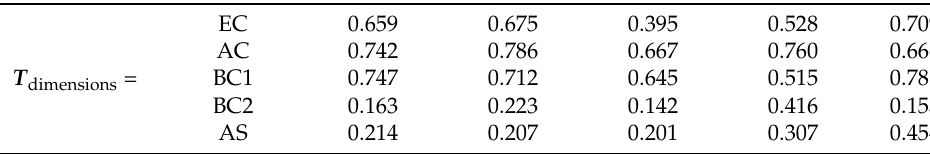
Table 9. Total relation matrix T dimensions of dimensions.